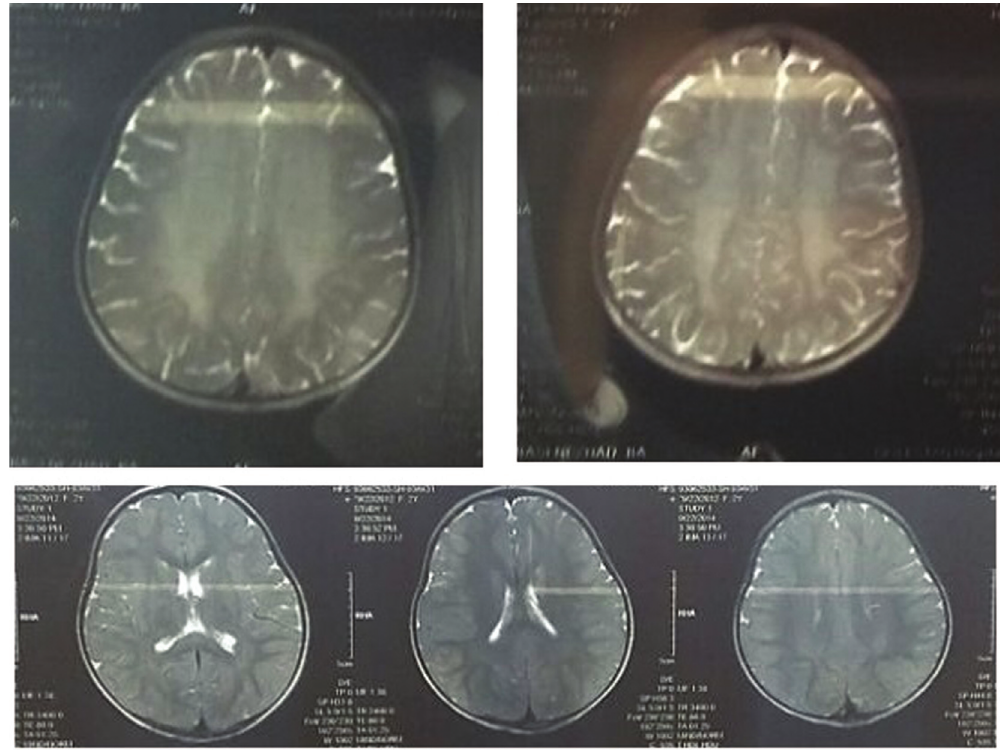
Figure 2 - Magnetic resonance imaging T2W sequence in patients showing bilateral, diffuse confluent hyperintensities in white